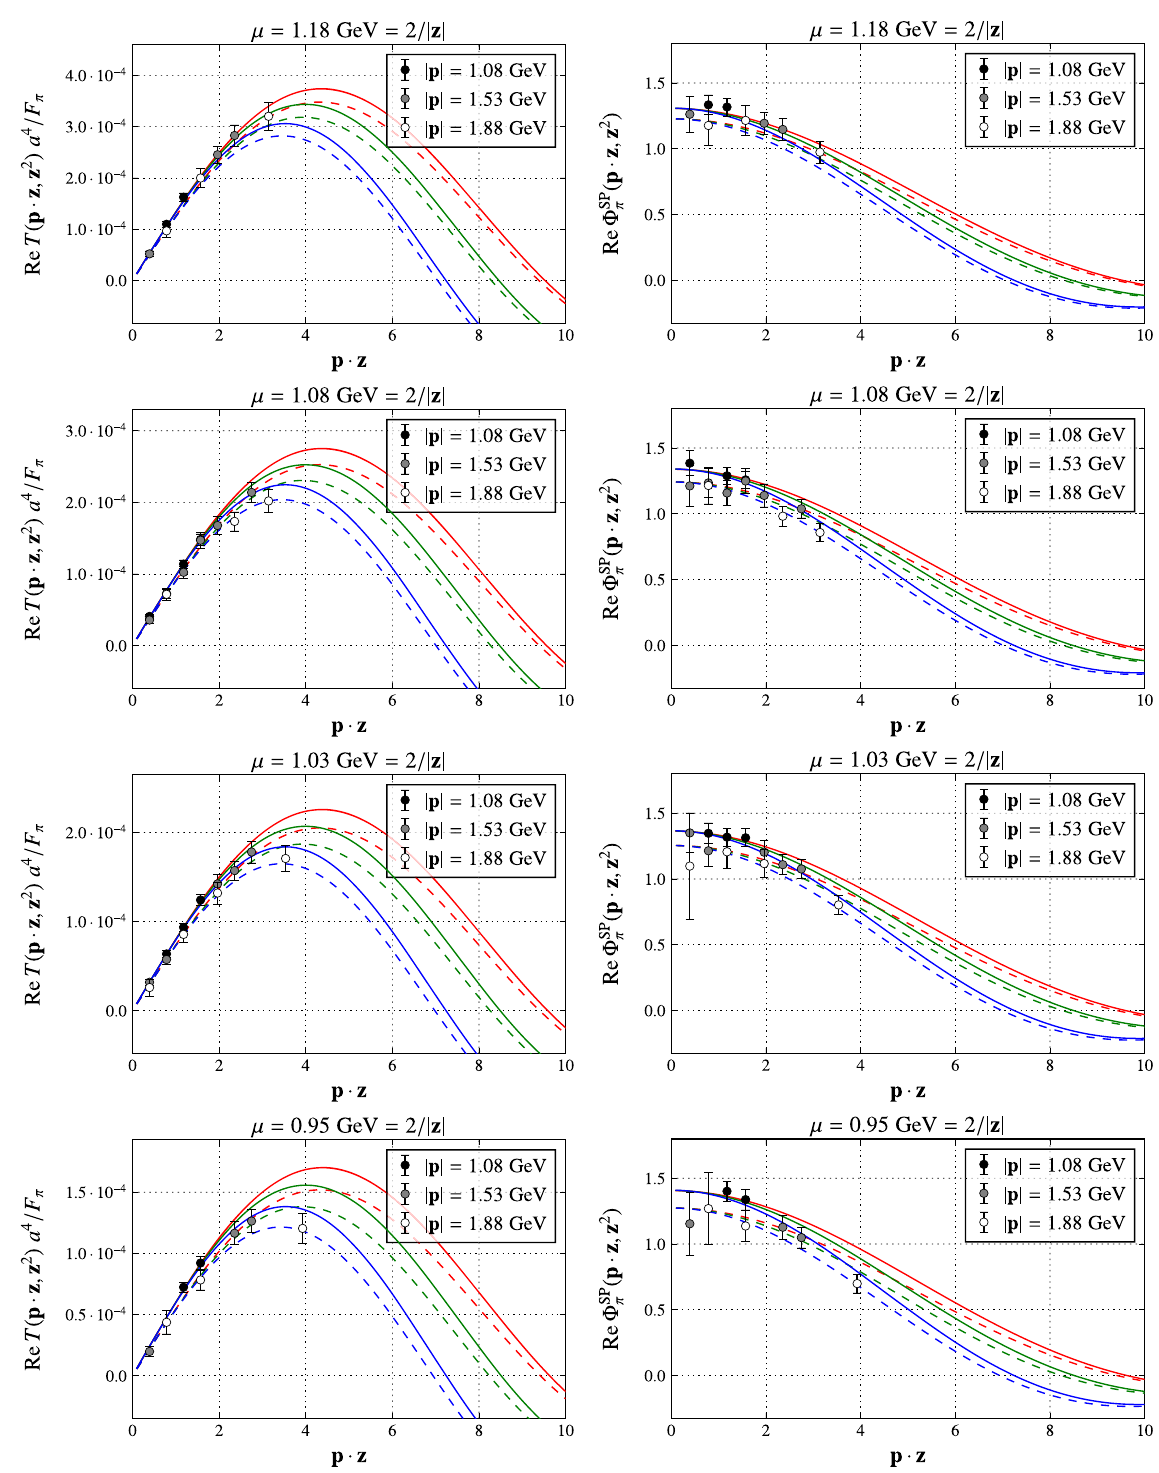
Fig. 7 Resultsfromthescalar-pseudoscalarchannelforfixedvaluesof the distance z 2 corresponding to perturbative scales around μ ≈ 1GeV. The errorbars only include the statistical error. Note that this comprises only a small subset of the available data. The left-hand-side plots dis- play the real part of the normalized matrix element T ( p · z , z 2 )/ F π ,